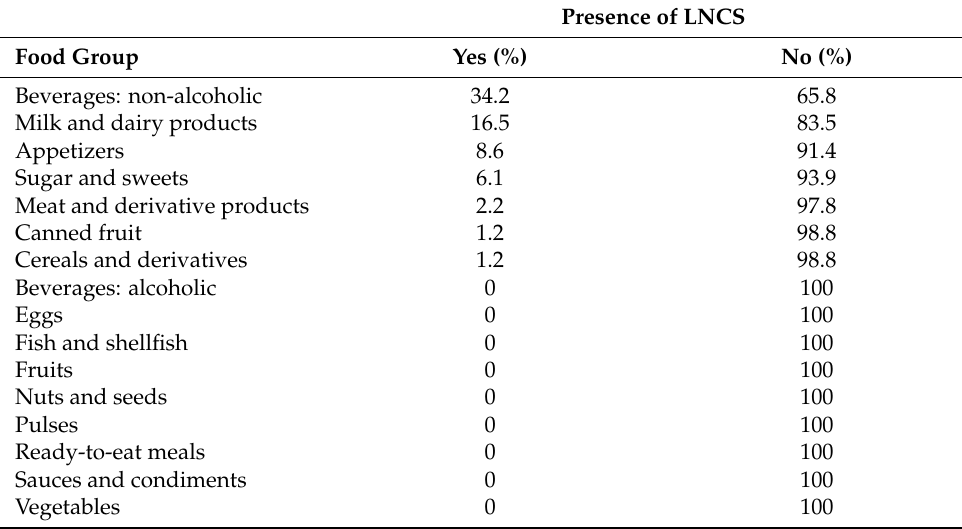
Table 2. Presence of low and no-calorie sweeteners (LNCS) in food groups consumed by the Por- tuguese